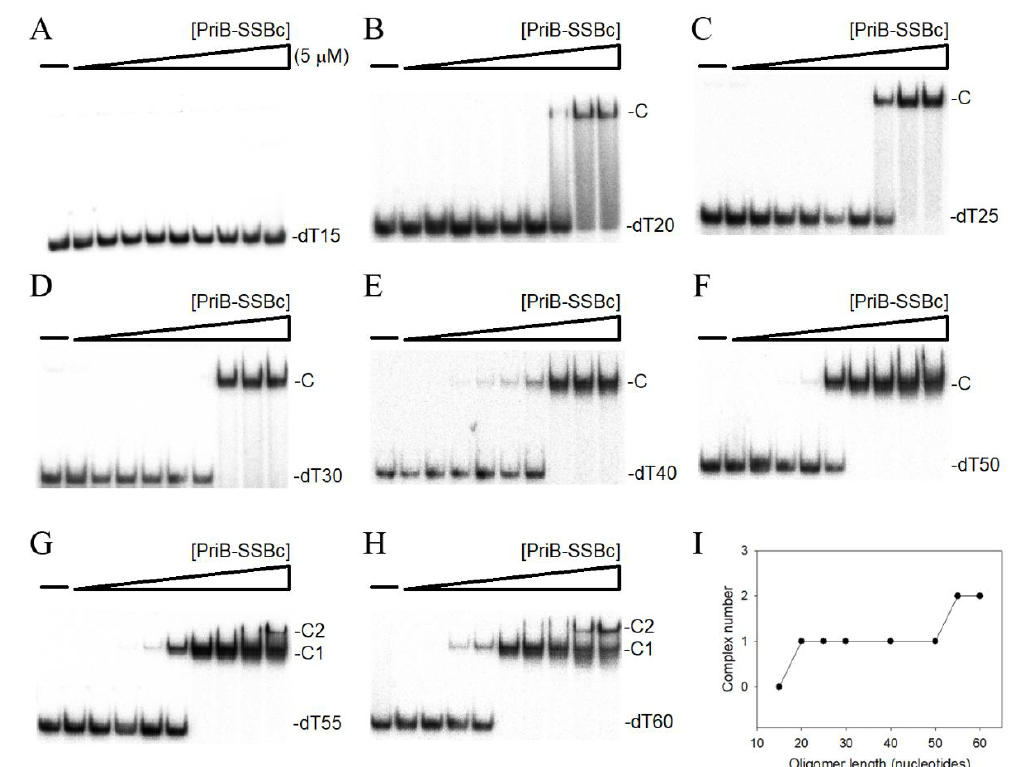
Figure 5. EMSA of PriB-SSBc. Protein (0, 19, 37, 77, 155, 310, 630, 1250, 2500, and 5000 nM) was incubated at 25 °C for 30 min with 1.7 nM of ( A ) dT15, ( B ) dT20, ( C ) dT25, ( D ) dT30, ( E ) dT40, ( F ) dT50, ( G ) dT55, or ( H ) dT60 in a total volume of 10 µ L in 20 mM Tris–HCl (pH 8.0) and 100 mM NaCl. ( I ) Summary of the complex number of PriB-SSBc. Complex number of PriB-SSBc as a function of the length of the ssDNA determined using EMSA.